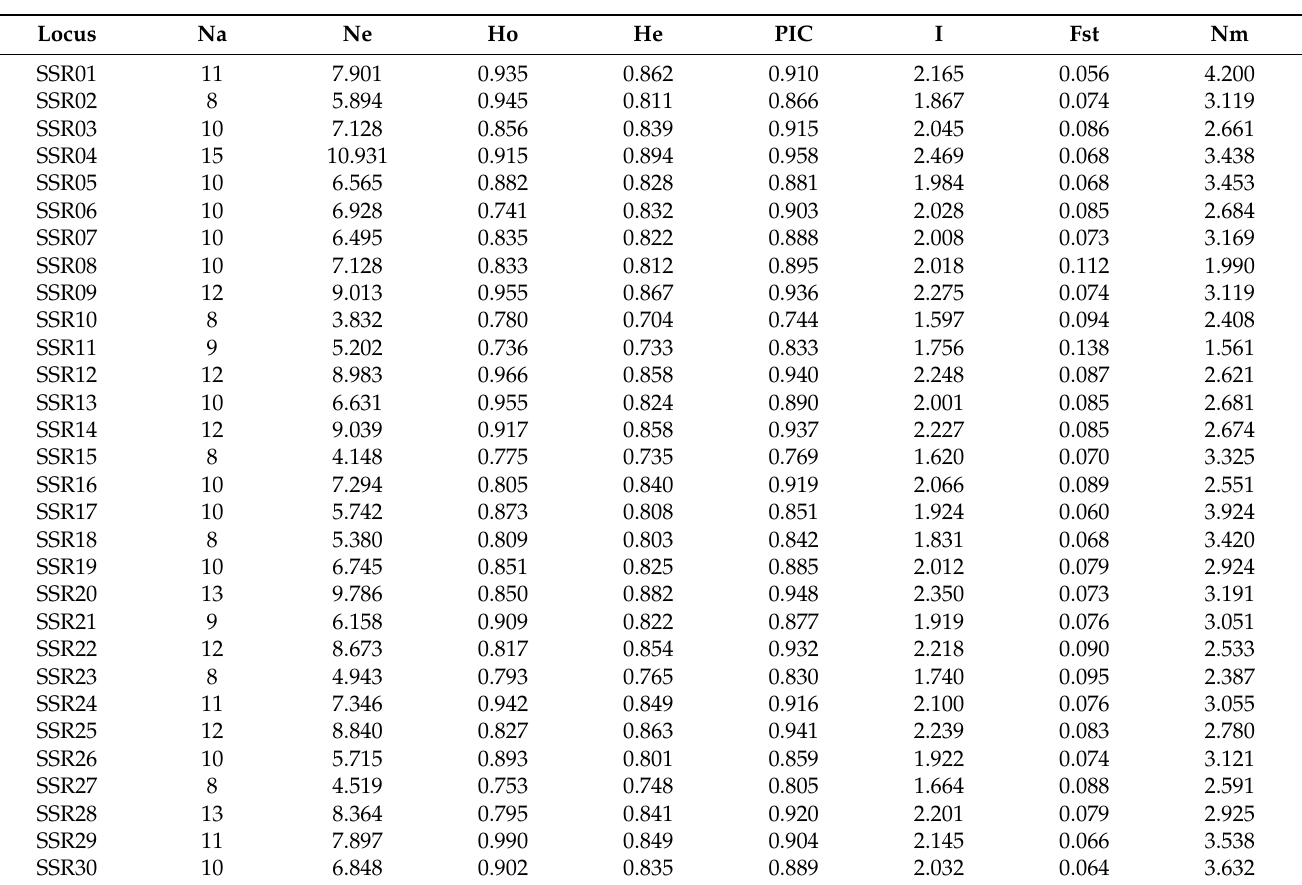
Table 2. Genetic diversity parameters of the 32 SSR